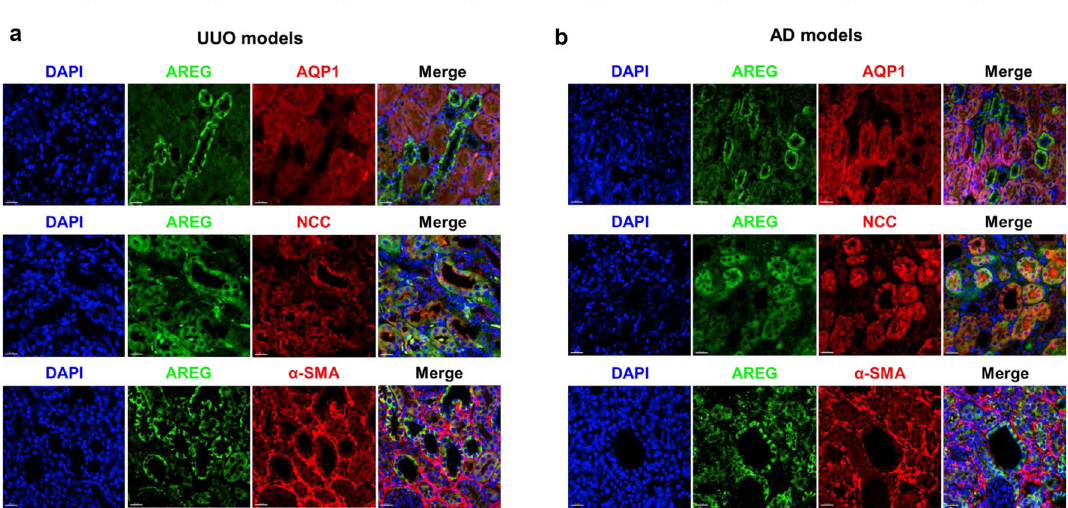
Figure 8. Representative confocal microscopy images of mouse kidney tissues at six days after UUO surgery or seven days after AD. The samples were co-stained for AREG (green), AQP-1 (red, proximal tubule), NCC (red, distal tubule), and α-SMA (red, myofibroblast), and with DAPI to identify the nuclei (blue). Original magnification: × 200. Scale bar, 20